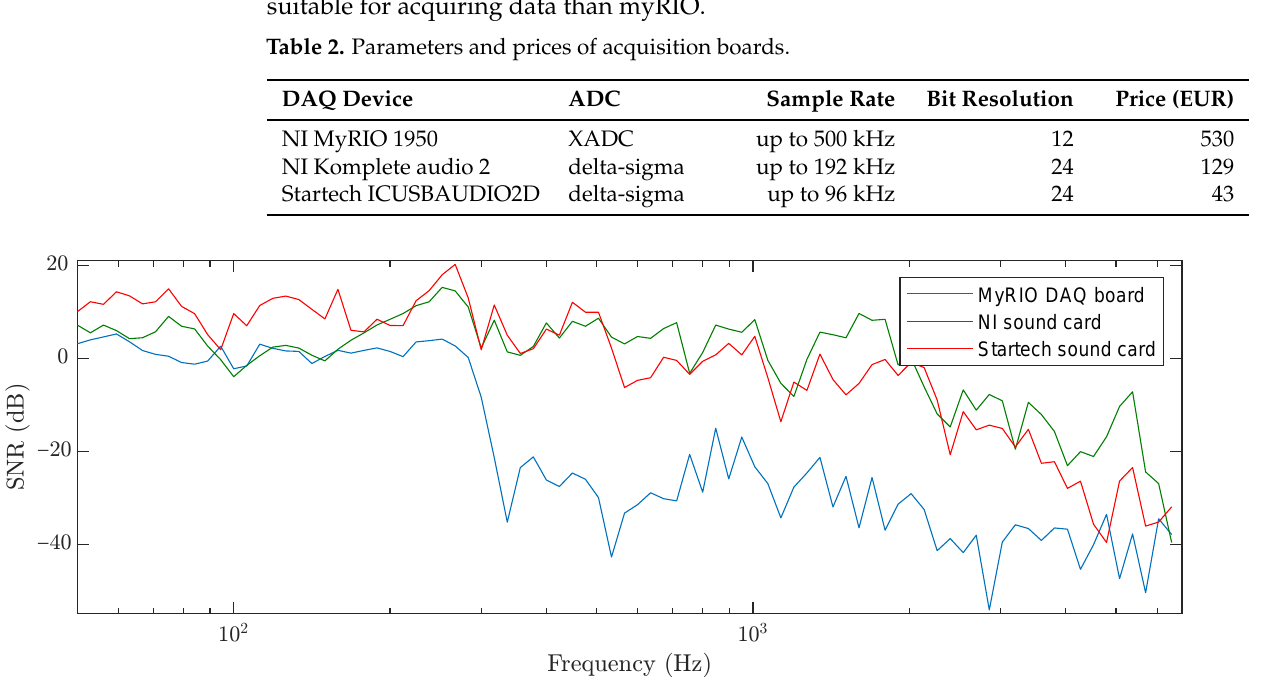
Figure 8. Comparison of the SNR in the frequency domain for myRIO and sound